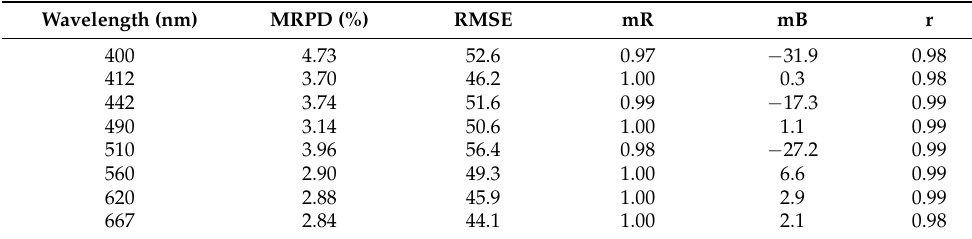
Table 3. Statistical parameters for the comparison of downwelling irradiance ( E s ) determined by SeaPRISM and RAMSES_AUTO at the Muping site, including median relative percentage difference